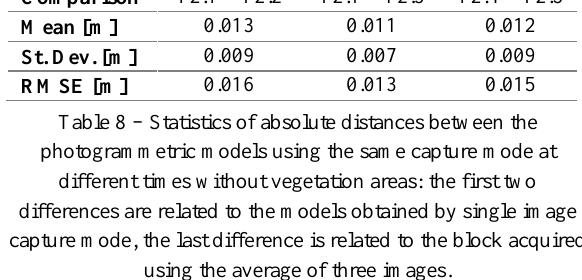
photogrammetric block acquired at the same time of the day with different capturing method.